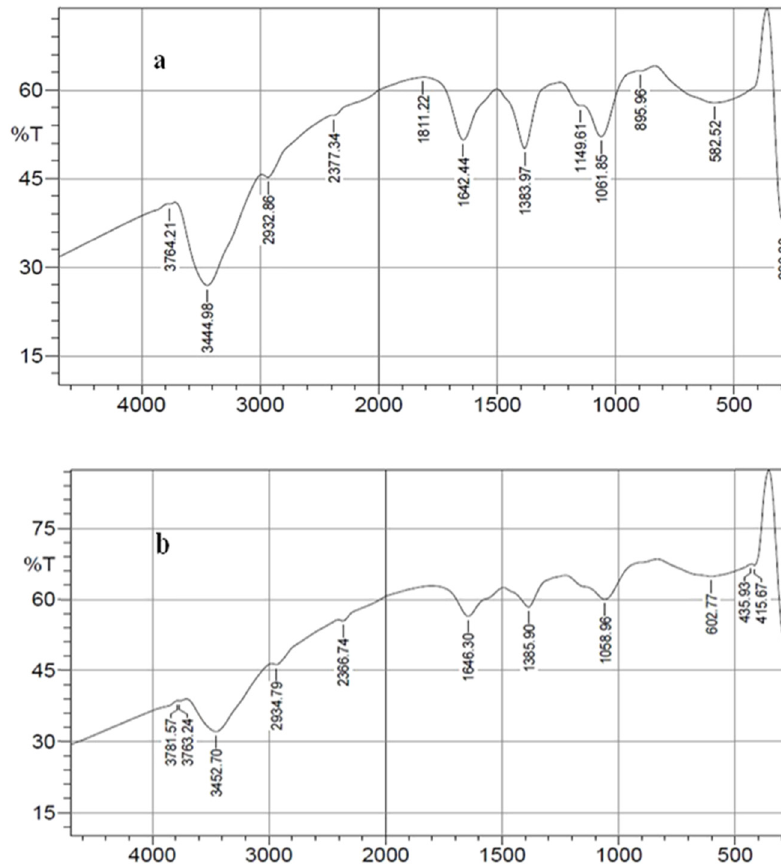
Figure 2: FTIR spectra of biogenic AgNPs by ( a ) C. elongata and ( b ) capping by acetic